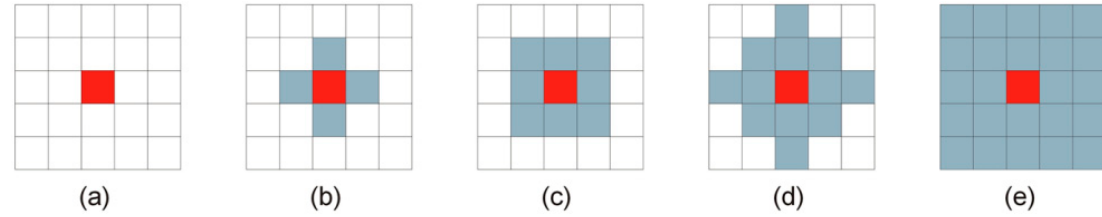
Figure 4. Neighborhoods for plane problems: ( a ) empty; ( b ) von Neumann; ( c ) Moore; ( d ) MvonN; ( e ) extended Moore.